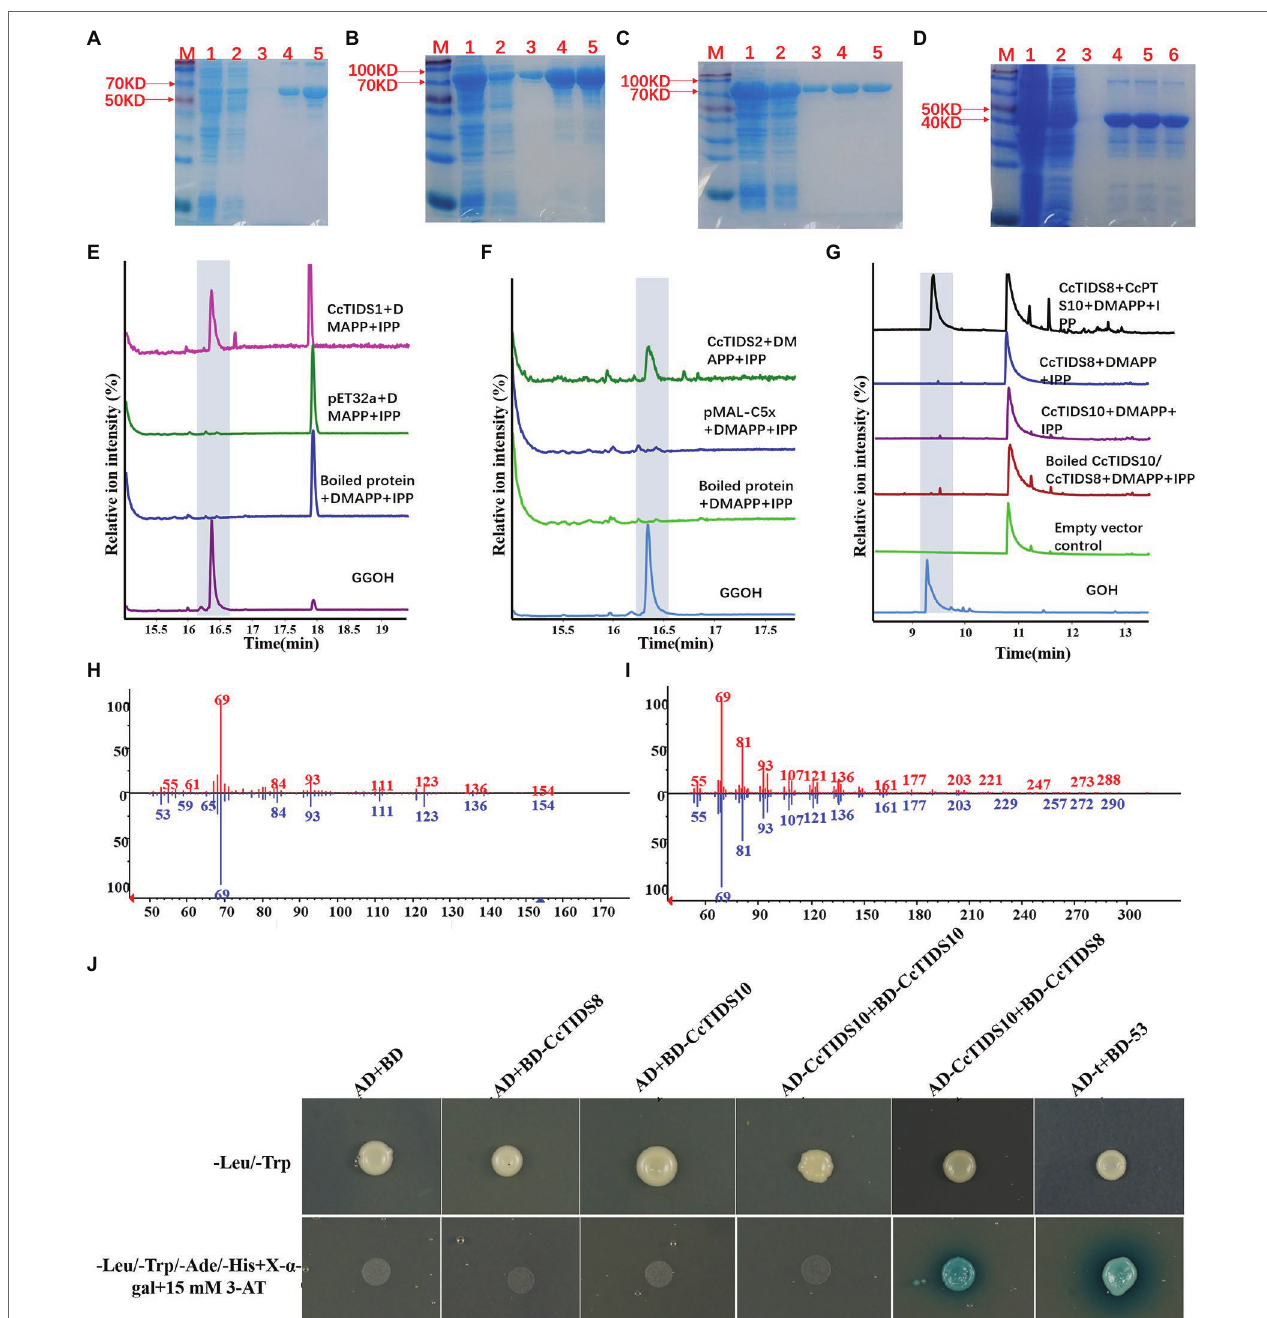
FIGURE 8 | Gas chromatography–mass spectrometry profile showing in vitro reaction products of C. camphora trans-prenyltransferases CcTIDS1, CcTIDS2, CcTIDS8, and CcTIDS9, where different prenyldiphosphates were used as substrates. Expression and purification of (A) CcTIDS1, (B) CcTIDS2, (C) CcTIDS8, and (D) CcTIDS10 recombinant protein from E. coli Rosetta (DE3) harboring pET32a(+)–CcTIDS1/CcTIDS10 or pMAL-C5x–CcTIDS2/CcTIDS8, where lane 1 shows the total protein after induction, 2 shows the soluble protein, 3–6 show the purified CcTIDS1 or CcTIDS2, CcTIDS8, or CcTIDS10 recombinant protein from the first to the fourth collected tube. The GC–MS chromatogram of the reaction products generated by (E) CcTIDS8 and CcTIDS10, (F) CcTIDS1, and (G) CcPTS2 and the acid hydrolysis products of geraniol (GOH) and gerylgeraniol (GGOH) standards. (H) Mass spectra of GOH standard (red) and products in the NIST14/Wiley275 library (blue). (I) Mass spectra of the GGOH standard (red) and products in the NIST14/Wiley275 library (blue). (J) Confirmation of the interaction between CcTIDS8 and CcTIDS10 using a yeast two-hybrid system, where blue color indicates an interaction. Yeast cells harboring both constructs were spotted on synthetic dropout (SD) medium lacking Ade, His, Leu, and Trp (SD/ − 4) to test for protein interactions. AD: pGADT7; BD: pGBDT7; AD-T: pGADT7::T; BD-53: pGBKT7-53. Cells co-transformed with pGADT7::T and pGBKT7-53 were included as a positive control, and pGADT7 and pGBDT7 as a vector